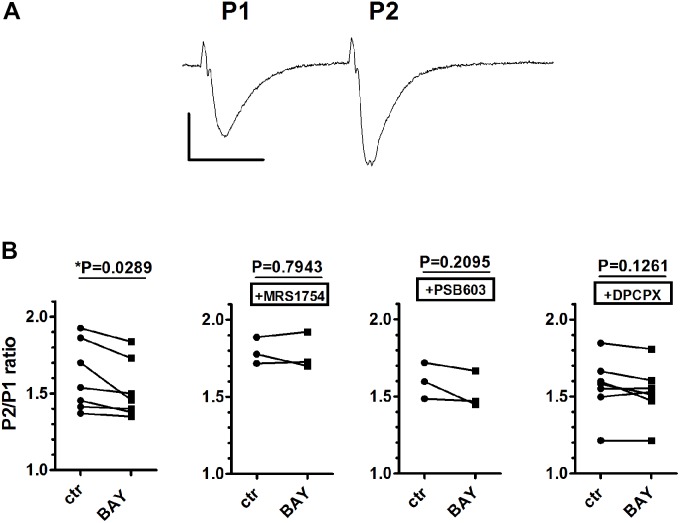
The selective stimulation of adenosine A2B receptors reduced paired-pulse facilitation (PPF) in rat hippocampal slices. (A) Trace of fEPSP responses to PPF protocol (40-ms interval), taken from a typical experiment. Calibration: 0.5 mV, 20 ms. (B) Each graph shows PPF quantified as the ratio (P2/P1) between the slope of the second fEPSP (P2) and the slope first fEPSP (P1). The effect of BAY606583 (BAY, 200 nM) on PPF was investigated in the absence (n = 7) or in the presence of MRS1754 (500 nM, n = 3), PSB603 (50 nM, n = 3), or DPCPX (100 nM, n = 7). ∗P < 0.05 vs. ctr, paired Student’s t-test.